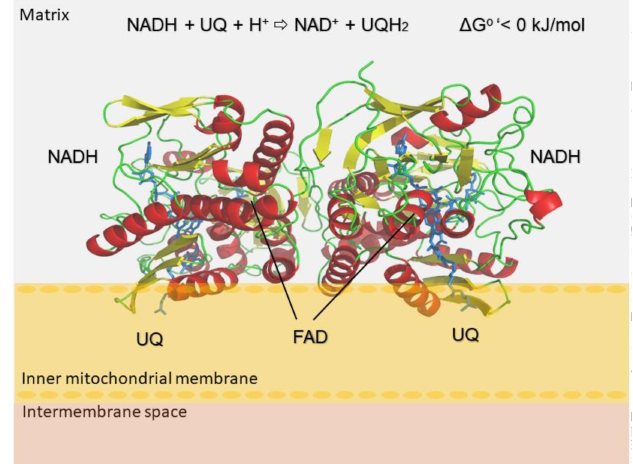
Figure 1. Oxidoreduction reaction of NDH-2 enzymes. Cartoon representation of the model structure of the NDH-2 from L. infantum . The homodimer representation of Li NDH2 homology model generated using Phyre2 server is presented in a cartoon style. Orientation and structural arrangement of the monomer units were obtained using 3D alignment with the used template structures (Protein Data Bank IDs: 4g6g, 4g73 and 5jwa [9,10]). The homodimer consists of reciprocally oriented monomers and is located on the surface of the mitochondria intermembrane. C-termini are embedded into the membrane layer (inner mitochondrial membrane). In depicted reaction: NADH/NAD + denote nicotinamide adenine dinucleotide protonated/deprotonated; UQ/UQH 2 ubiquinone deprotonated/protonated and FAD flavin adenine